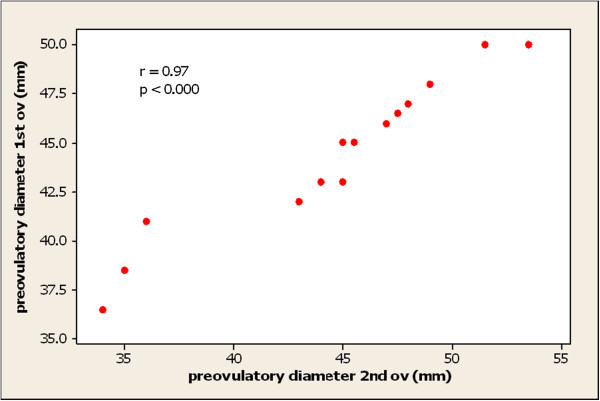
Scatter plot correlating pre-ovulatory follicular diameter in individual mares. (1st ovulations with 2nd/3rd ovulations. First halves only).